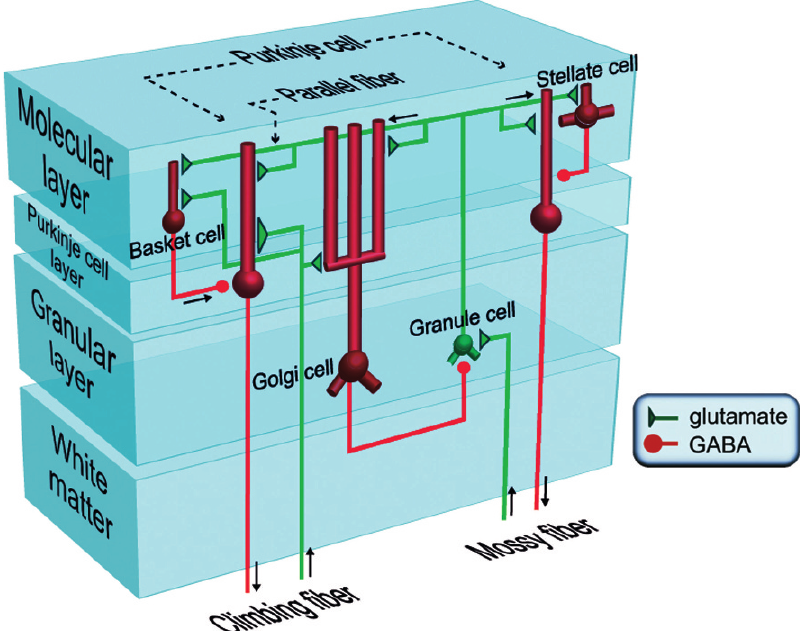
Figure 2 – The cerebellum contains three layers and five distinct types of neurons. Glutamatergic neurons are shown in green and GABAergic neurons in red. In schizophrenia, a deficit in the glutamatergic NMDA receptor may lead to a GABAergic deficit and, as a consequence, to disturbed